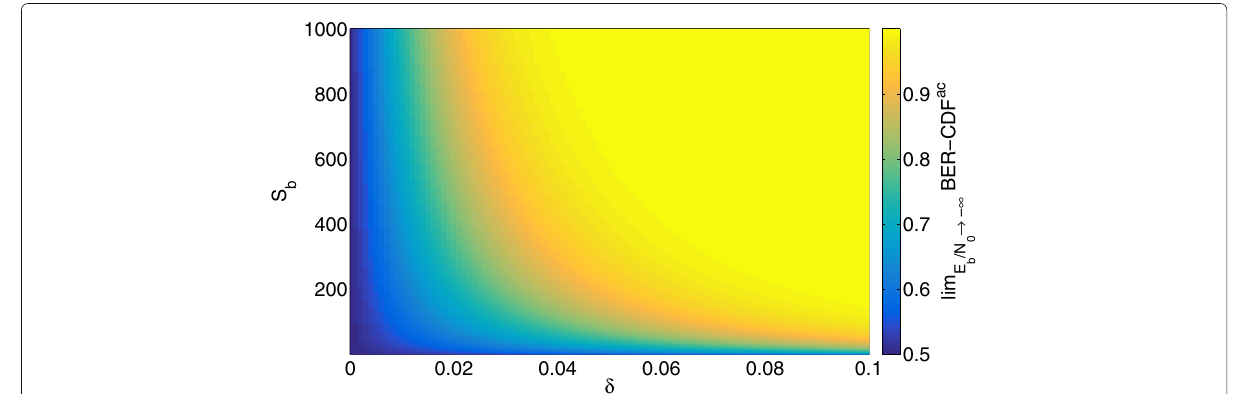
Fig. 5 Limiting value of the BER-CDF ac metric as E b / N 0 goes to −∞ as a function of δ and S b